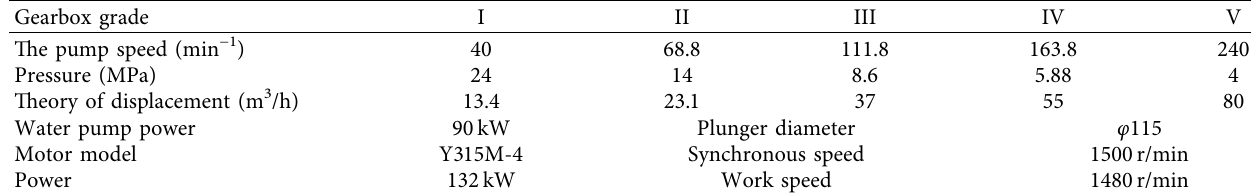
Table 9: DZB-80/35 performance parameters of the grouting